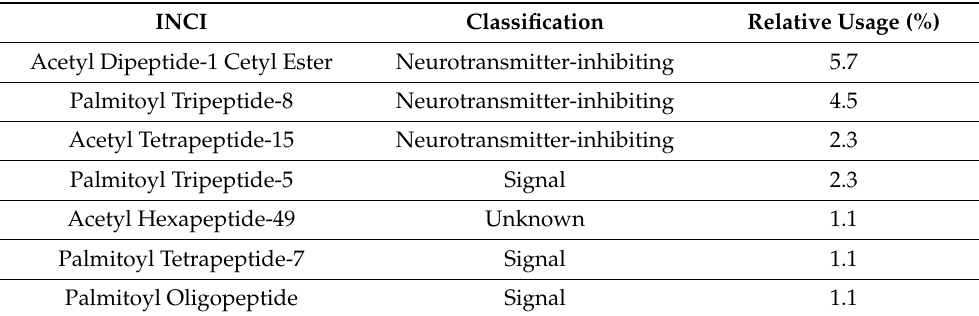
Table 1. Peptides found at INCI lists of cosmetic products for sensitive skin and their relative usage